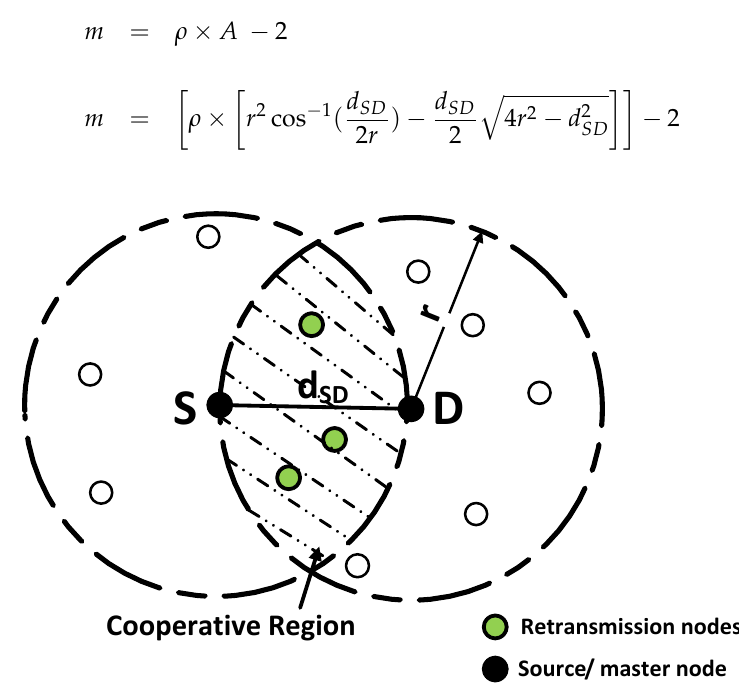
Figure 2. Cooperative region and retransmission